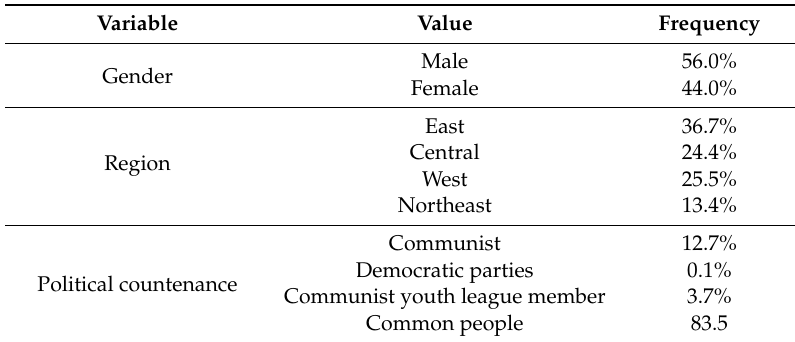
Table 3. Descriptive statistics of nominal variables.